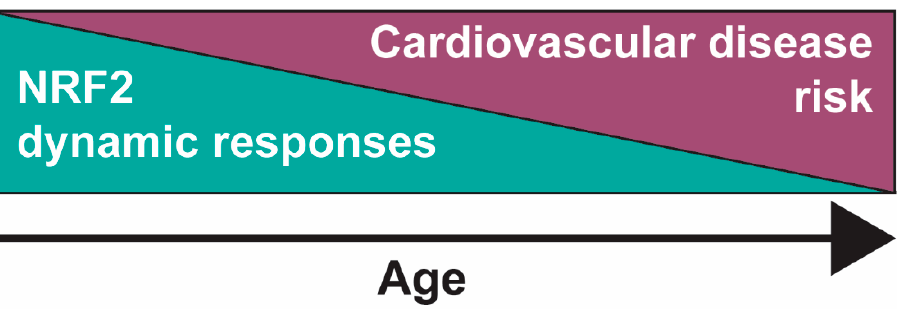
Figure 3. The propensity for NRF2-mediated coordination of dynamic responses to intracellular stressors such as increased ROS, xenobiotics or cardiotoxic drugs is decreased during physiological ageing. Cells of the cardiovascular system are therefore more susceptible to accumulative damage and tissue dysfunction, progressing towards disease